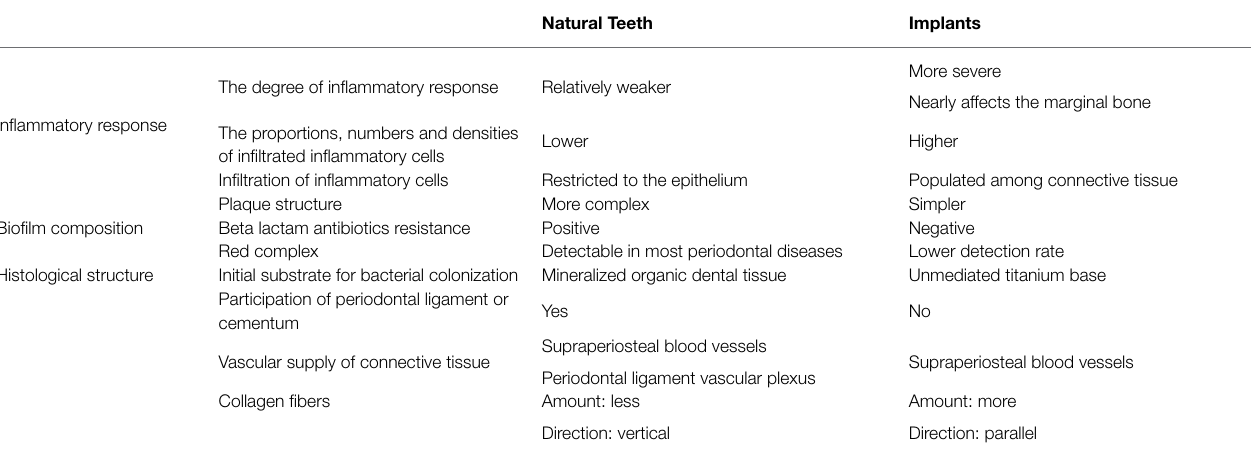
TABLE 2 | Differences between periodontal diseases and peri-implant